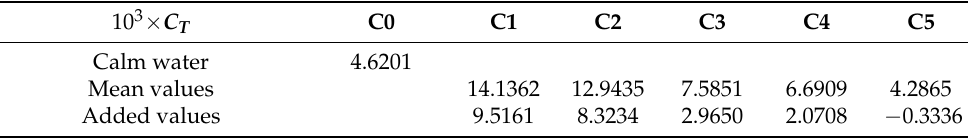
Table 29. Added resistance in waves computed for H S = 0.045 and Fr =